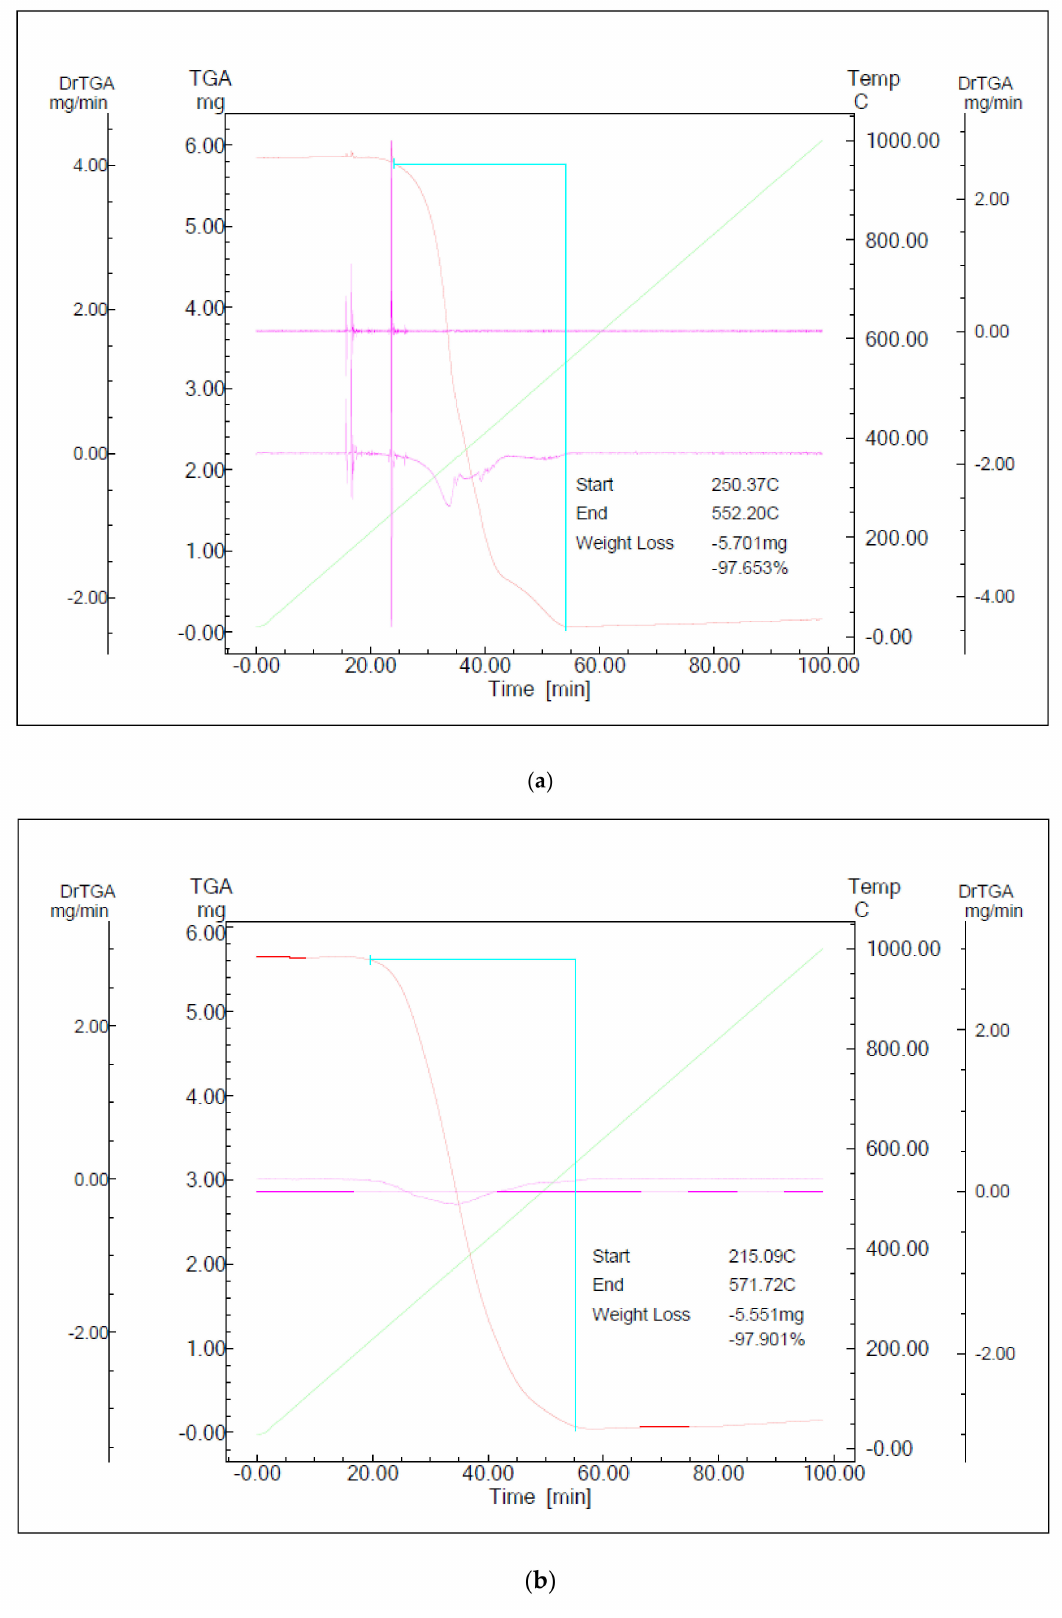
Figure A13. TGA Sample AA-25T-75M ( a ) Nitrogen atmosphere ( b ) air